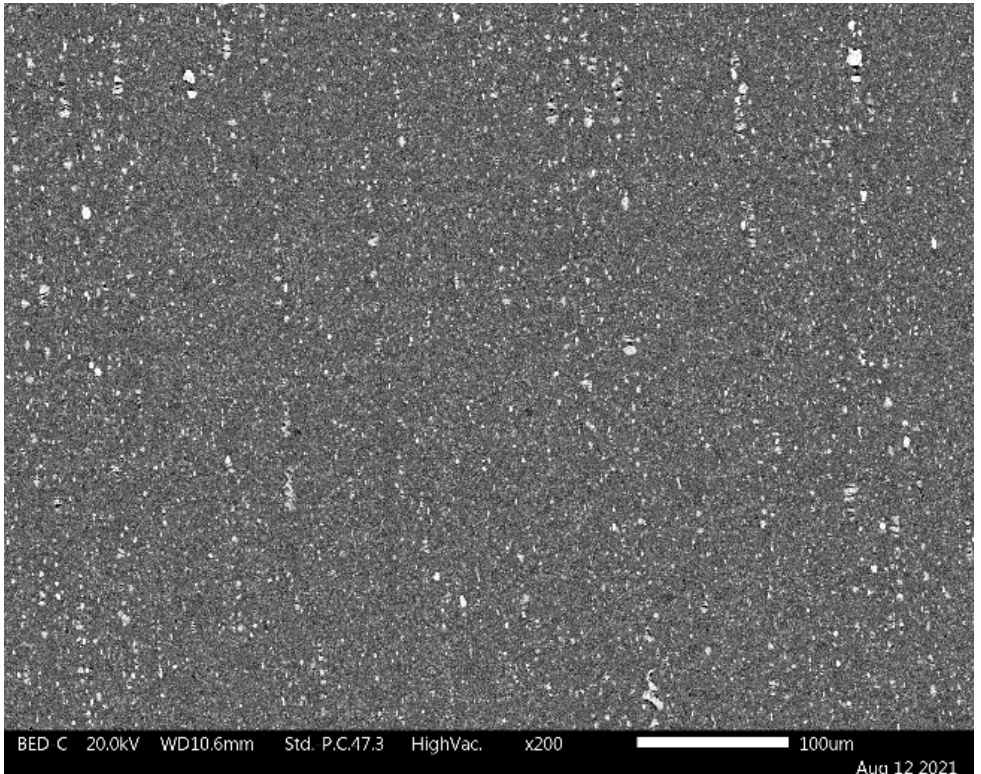
Figure 6. The thermal deformation microstructure of 2A97: ( a ) normal; ( b ) local amplification.